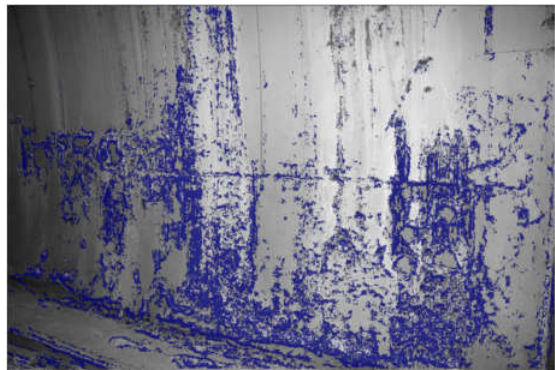
Figure 5. Areas with any type of defect are marked with blue dots.